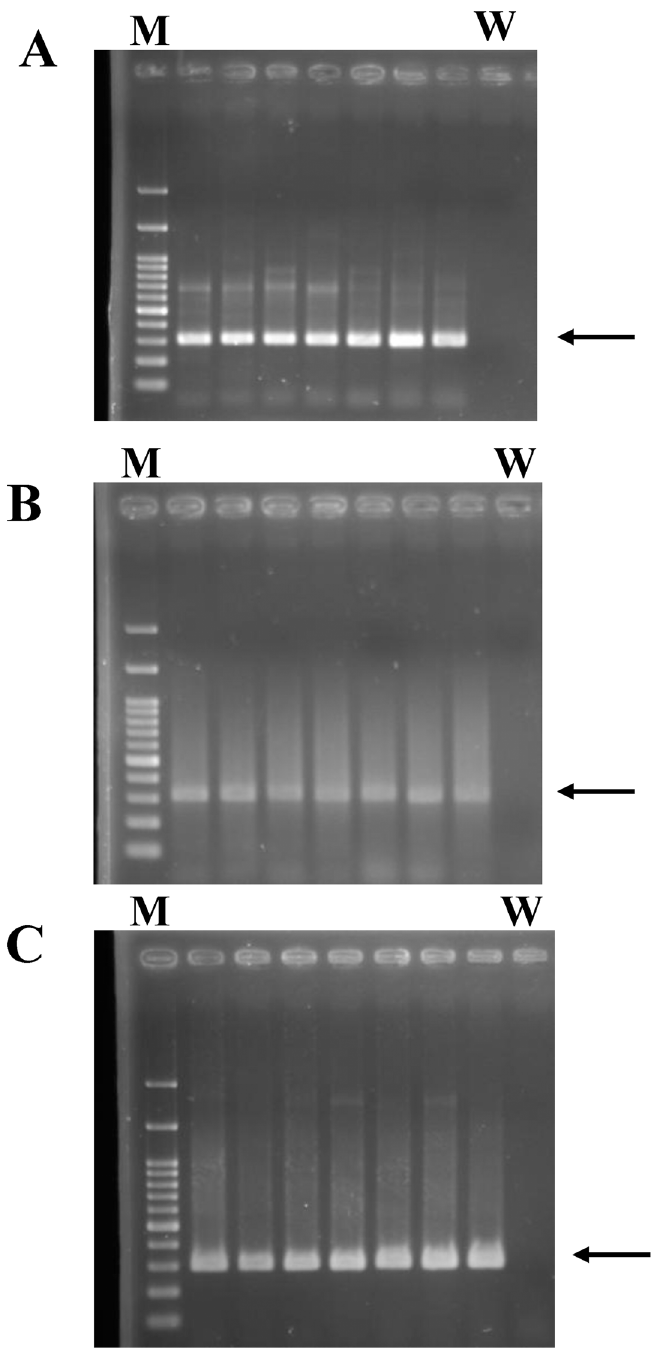
Fig 3. Representative gel electrophoresis of PCR amplicon using sequencing primers from different DNA preparations. (A) PCR amplicon generated from genomic DNA purified from peripheral blood cells. (B) PCR amplicon generated from Guthrie blood spot. (C) PCR amplicon generated from a crude lysate of peripheral blood cells (C). M: DNA markers; the arrow indicates the PCR amplicon with the size of 307 bp. W: indicates water blank as a negative control.